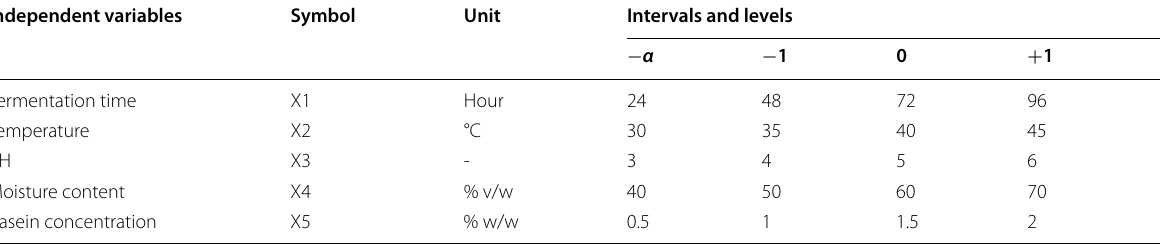
Table 1 Coded levels of independent variables employed in the CCD Independent variables Symbol